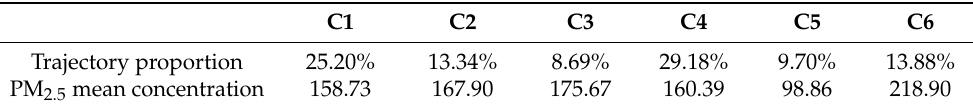
Table 2. The mean concentrations of PM 2.5 in different